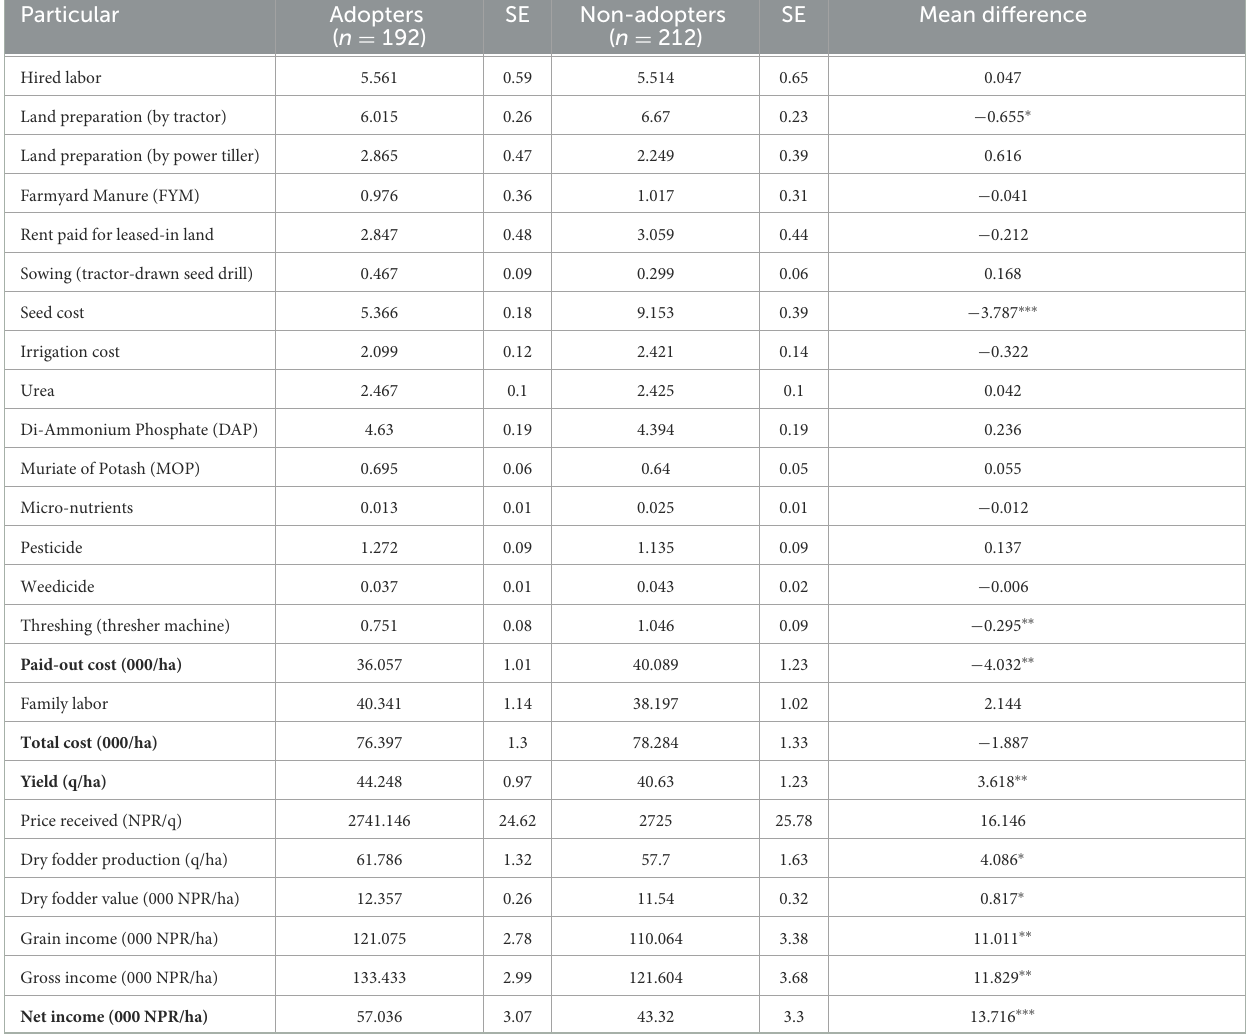
TABLE 2 Cost of cultivation of adopters and non-adopters of RH-10 hybrid (values in 000 NPR/ha). Particular Adopters SE Non-adopters SE Mean ( n = 192) ( n = 212)